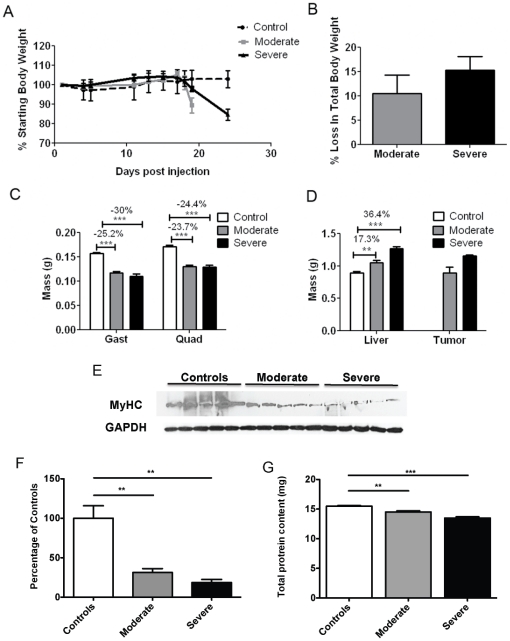
Characterization of C26 cachexia.A, B, Body weight changes for control mice and for mice injected with C26 tumor cells. Mice euthanized on day 19 had lost ∼10% body weight, considered moderate cachexia. Mice euthanized on day 24 had lost ∼15% body weight, considered severe cachexia. C, Significantly decreased quadriceps and gastrocnemius weights were observed with C26 cachexia. Differences were not significant in muscles from moderate versus severe cachexia. D, Liver weight and tumor weight both increased with severity/duration of cachexia. E, Representative Western blotting for Myosin Heavy Chain (MyHC) in quadriceps muscle from both control and tumor bearing mice. F, Densitometric quantification of the Western blotting for MyHC protein shows a marked reduction in both moderate (−69% vs. controls) and severe (−81% vs. controls) cachexia. G, Total protein content in quadriceps muscle from control and tumor-bearing mice. Protein content is significantly reduced in both moderate (−7% vs. controls) and severe (−13% vs. controls). n = 4–5 per group; **P<0.01, ***P<0.001.